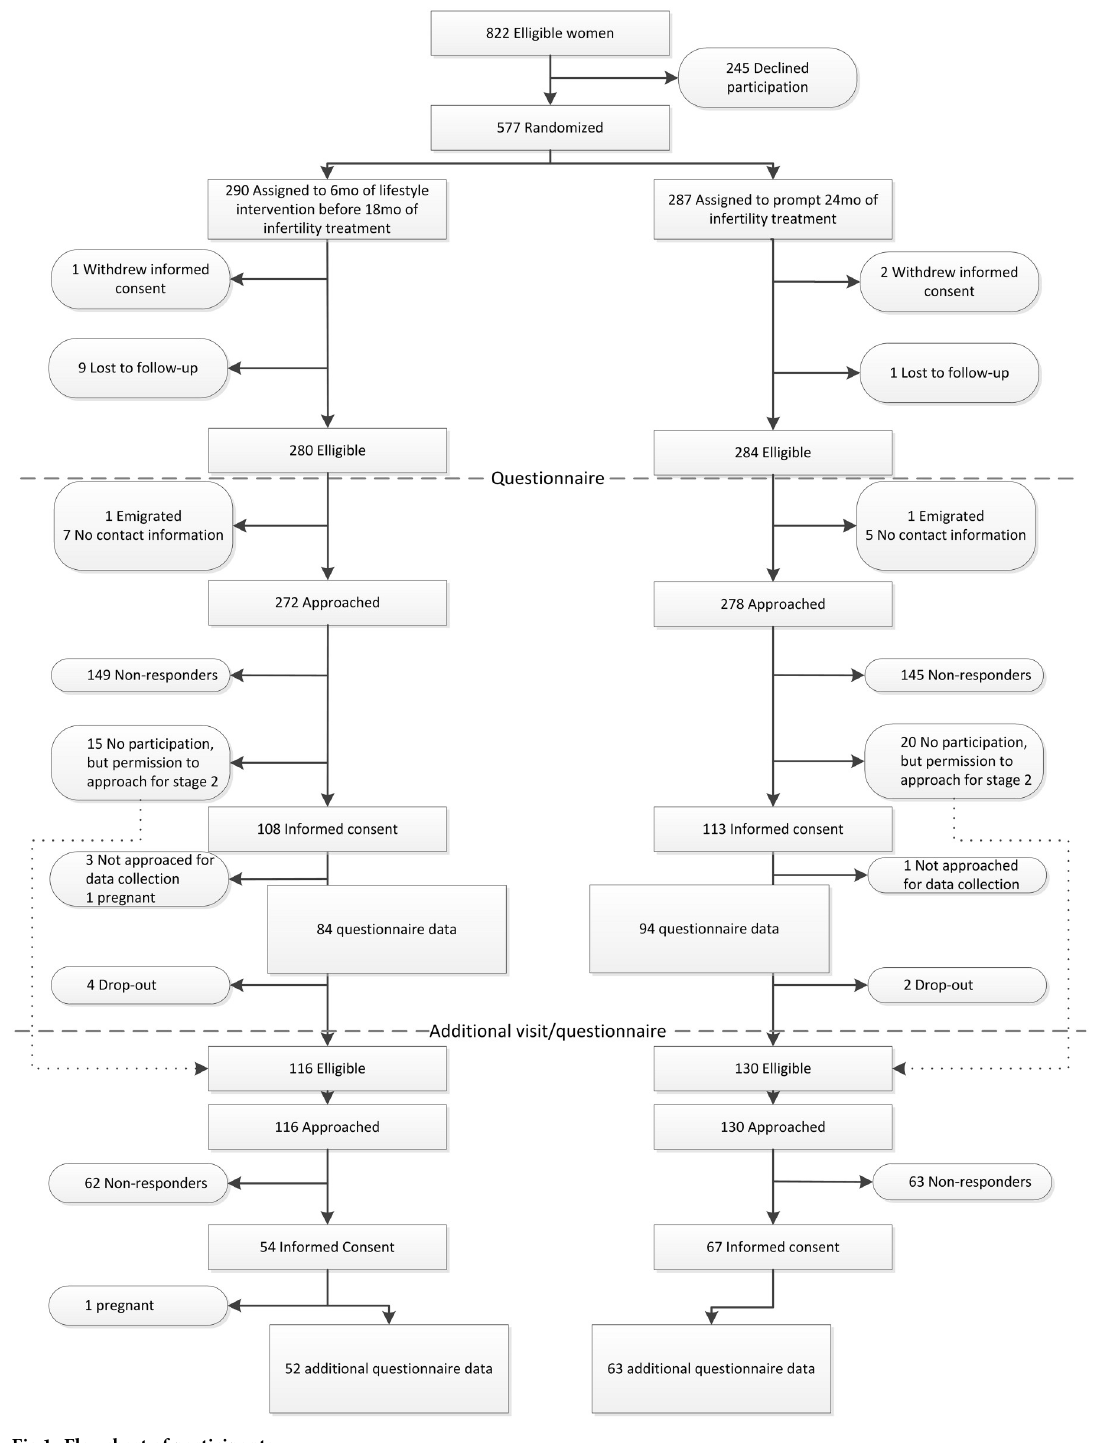
Fig 1. Flowchart of participants.